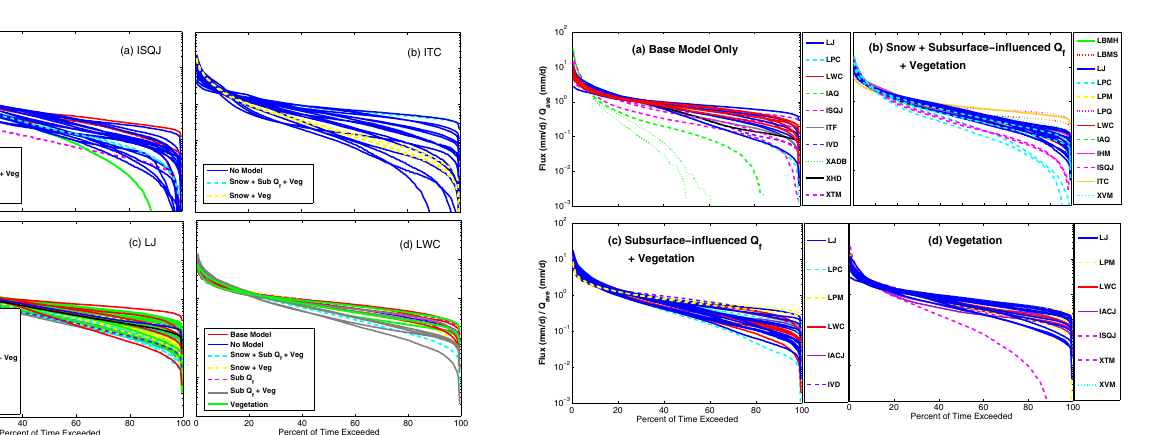
Fig. 4. FDCs for total streamflow within the 4 main catchment classes, grouped by model process class (Note that (a) and (b) rep- resent drier catchments with mildly seasonal rainfall P , while (c) and (d) represent wetter catchments with little seasonality in P) .